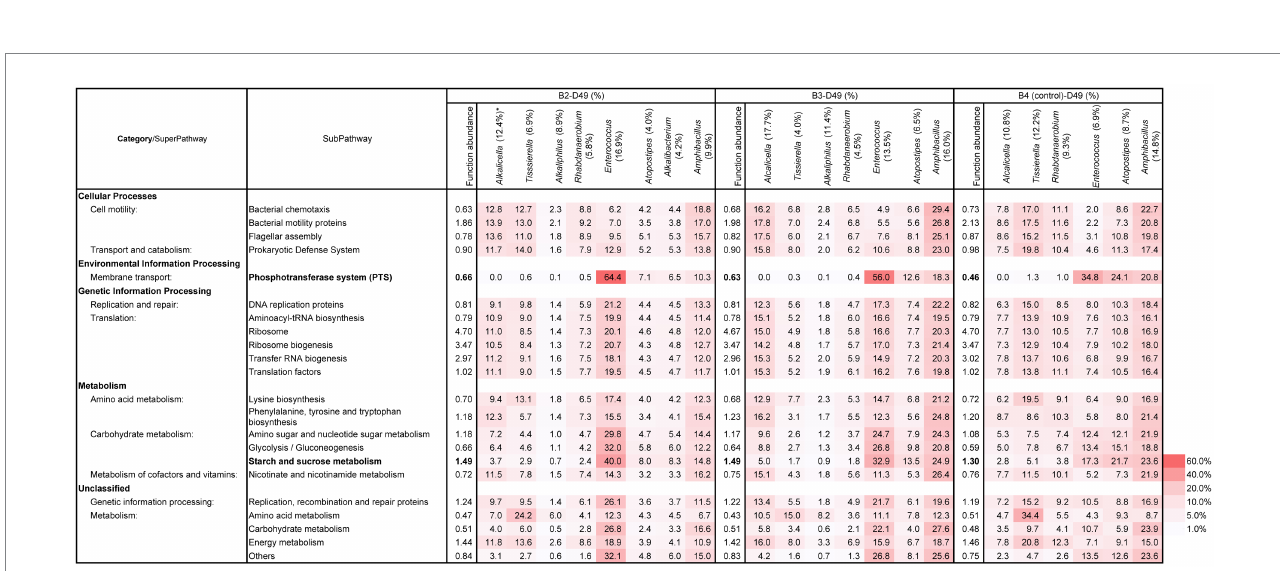
FIGURE 7 Functional abundance ratio (%) of the total subpathways and the contributing ratio (%) of the major constituent taxa in the subpathways related to the initiation and enhancement of indigo reduction at D49 samples in B2–4B. *: The number in the parentheses is the existence ratio (%) in the microbiota. The metagenomic prediction produced using PICRUSt2 and BURRITO is shown. There important subpathways and the functional abundance ratios are indicated in bold letters. B, batch; D, day.